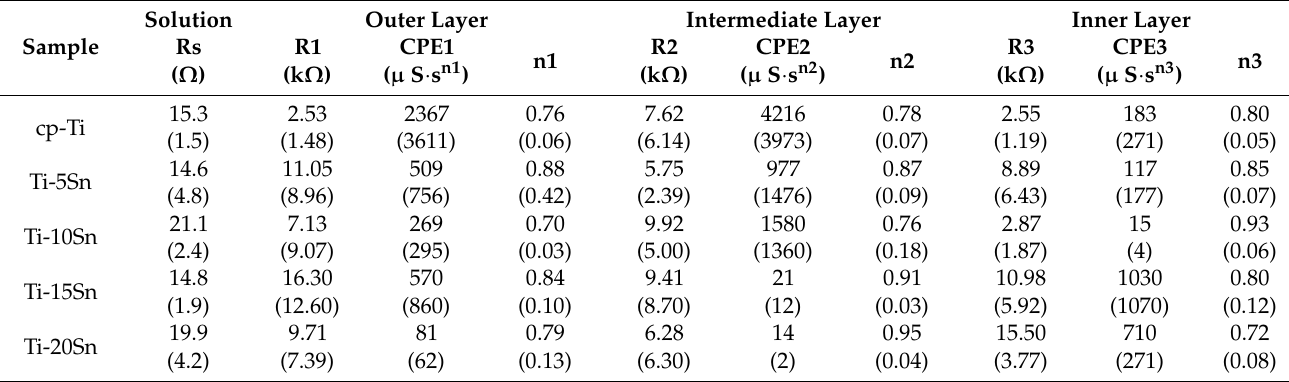
Table 2. The impedance parameters of cp-Ti and Ti-Sn alloys ( n = 3).